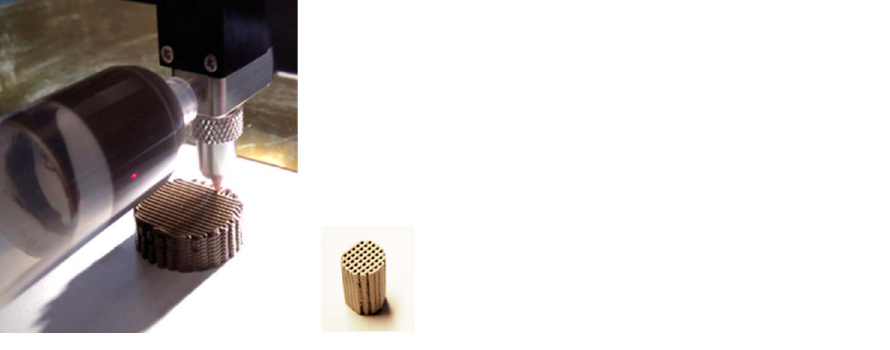
Figure 1. ( left ) Photo of catalyst structures directly printed from JM’s reference catalyst powder (Mn–Na–W/SiO 2 ) using an NScrypt printer; ( right ) cylinders of smaller dimensions were cut to fit a 0.6 cm